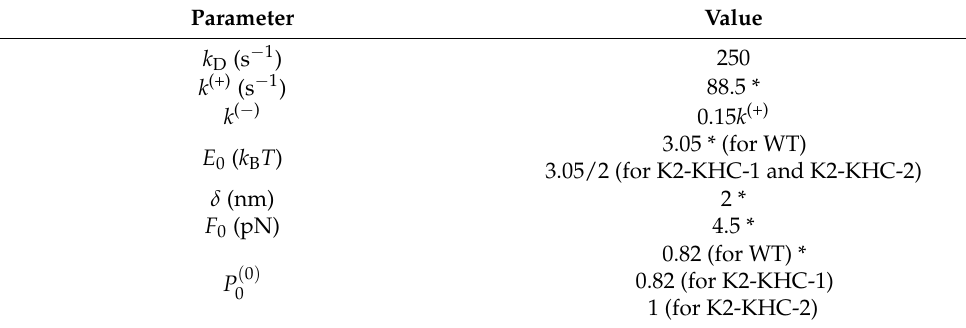
Table 3. Parameter values for kinesin-2 KIF3AB